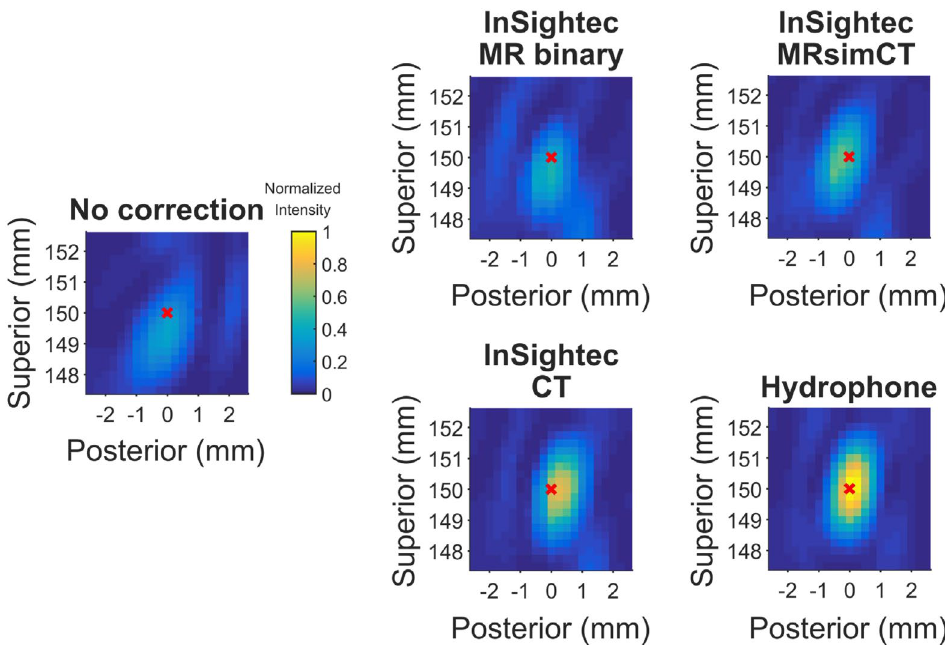
Figure 4. 2D cross section raster scans of the refocused focal spot (skull A). The sagittal view is shown. These cross sections are a subset of the 3D volume scans acquired. A red x marks the position of the target, which was placed at the geometric focus. The focal spot maximum may be out of plane. Figure 5 shows quantitative metrics for all three